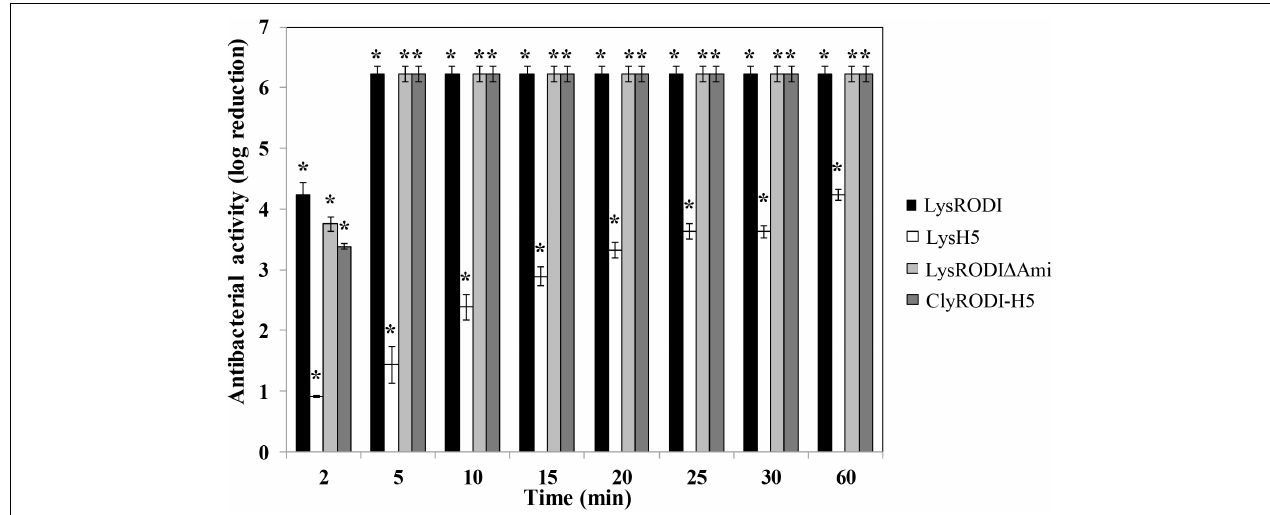
FIGURE 1 | Time-kill curve of S. aureus Sa9 (10 6 CFU/ml) treated with equimolar amounts of different engineered and parental proteins (0.1 µ M). The results (means ± SDs of three replicates) are reported as bacterial reduction (log 10 units) quantified as the relative inactivation in log units [log 10 (N 0 /N i ); N 0 is the initial number of cells and N i is the number of residual cells counted after treatment]. Bars having an asterisk are statistically different ( p < 0.05) from the untreated control, according to the Student’s t -test.